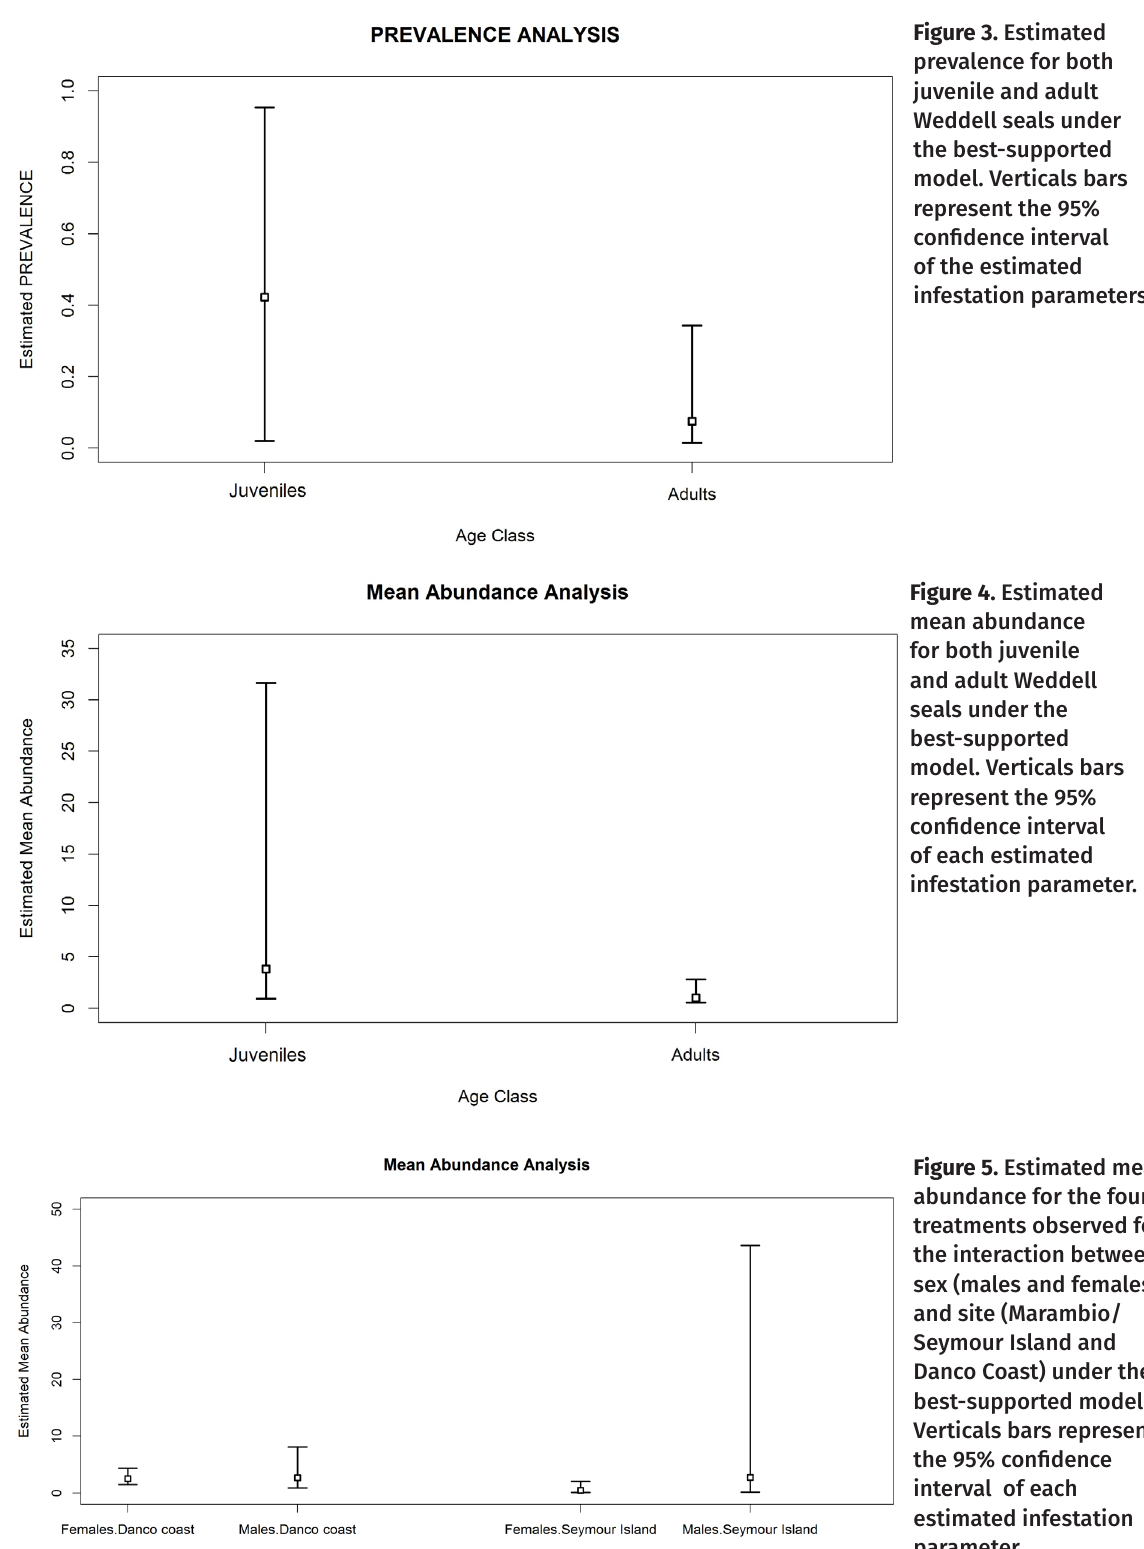
Figure 3. Estimated prevalence for both juvenile and adult Weddell seals under the best-supported model. Verticals bars represent the 95% confidence interval of the estimated infestation parameters.